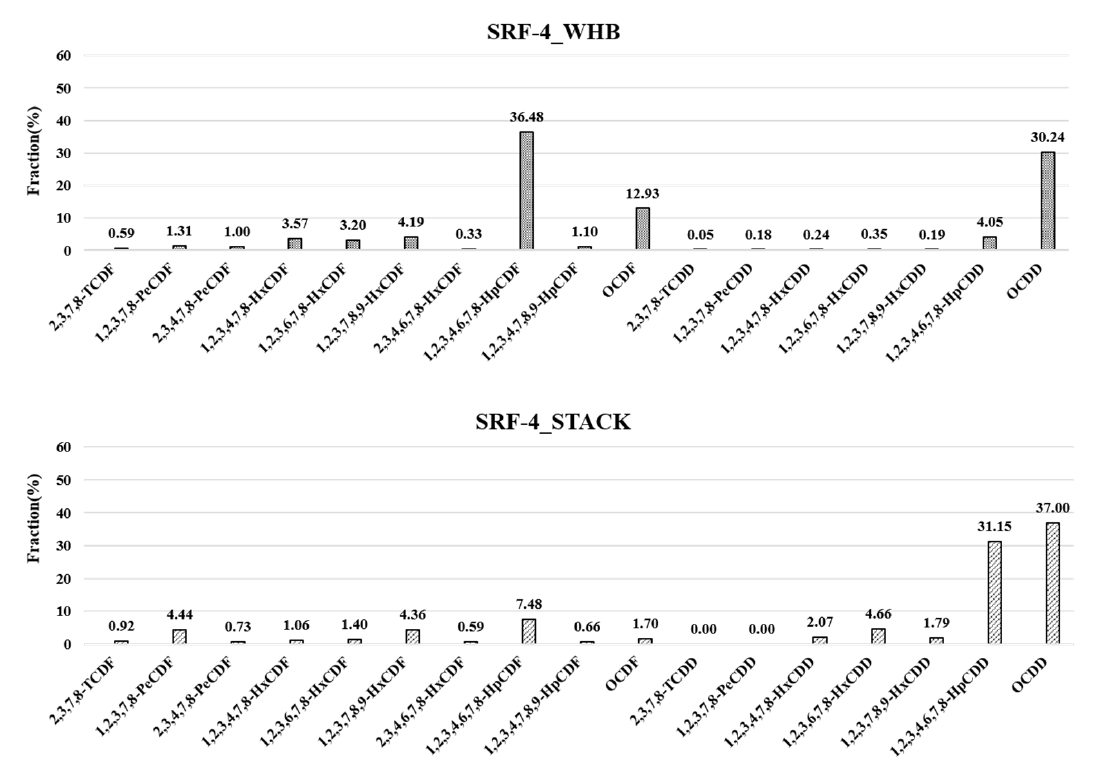
Figure 9. PCDD/DFs congener pattern in an SRF-4 incineration plant.